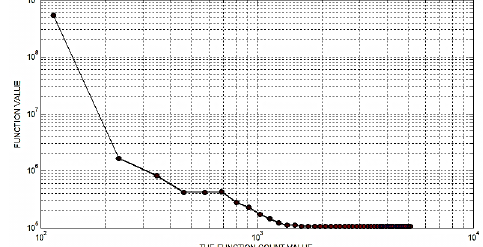
Figure 11. The log plots of optimization run of the